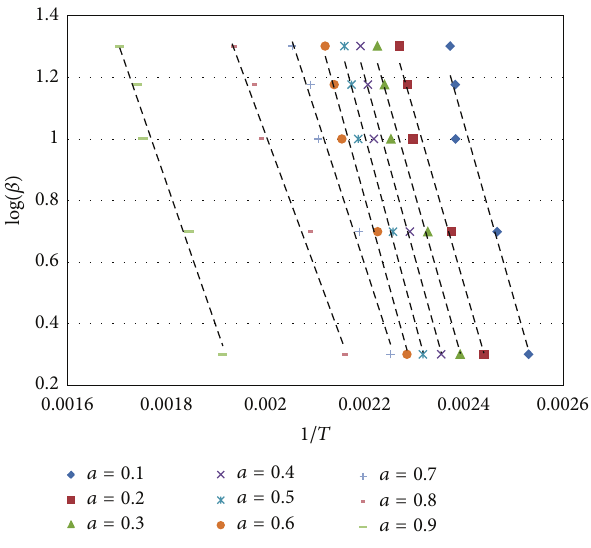
Figure 9: Ozawa analysis of mcallisterite.